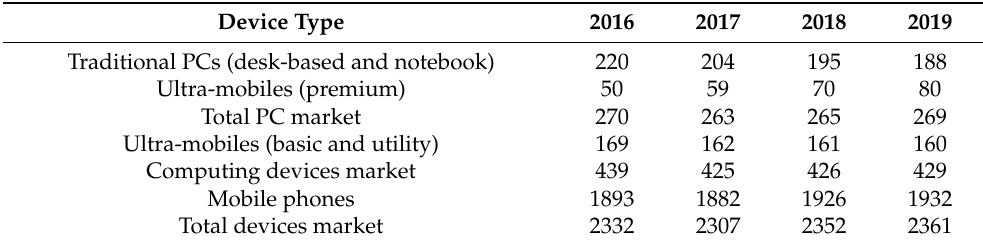
Table 1. Worldwide device shipments by device type, 2016–2019 (millions of units) [5]. Device